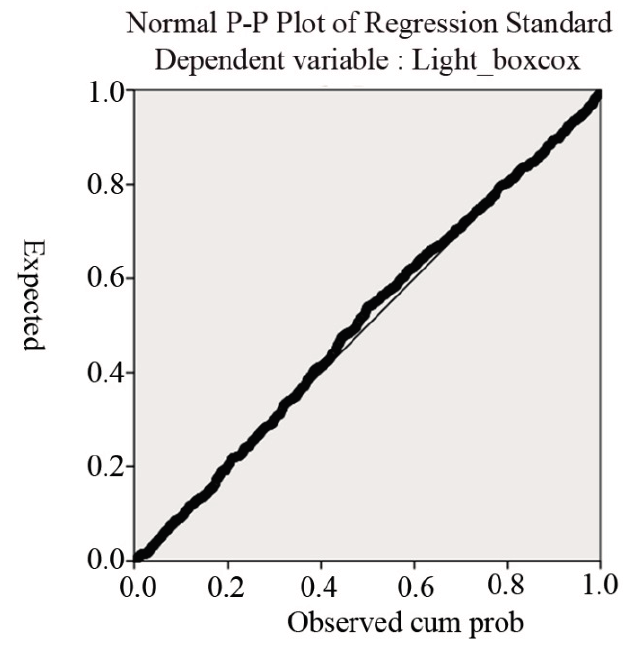
Figure 10. Standardized regression residuals of normal P-P diagram.